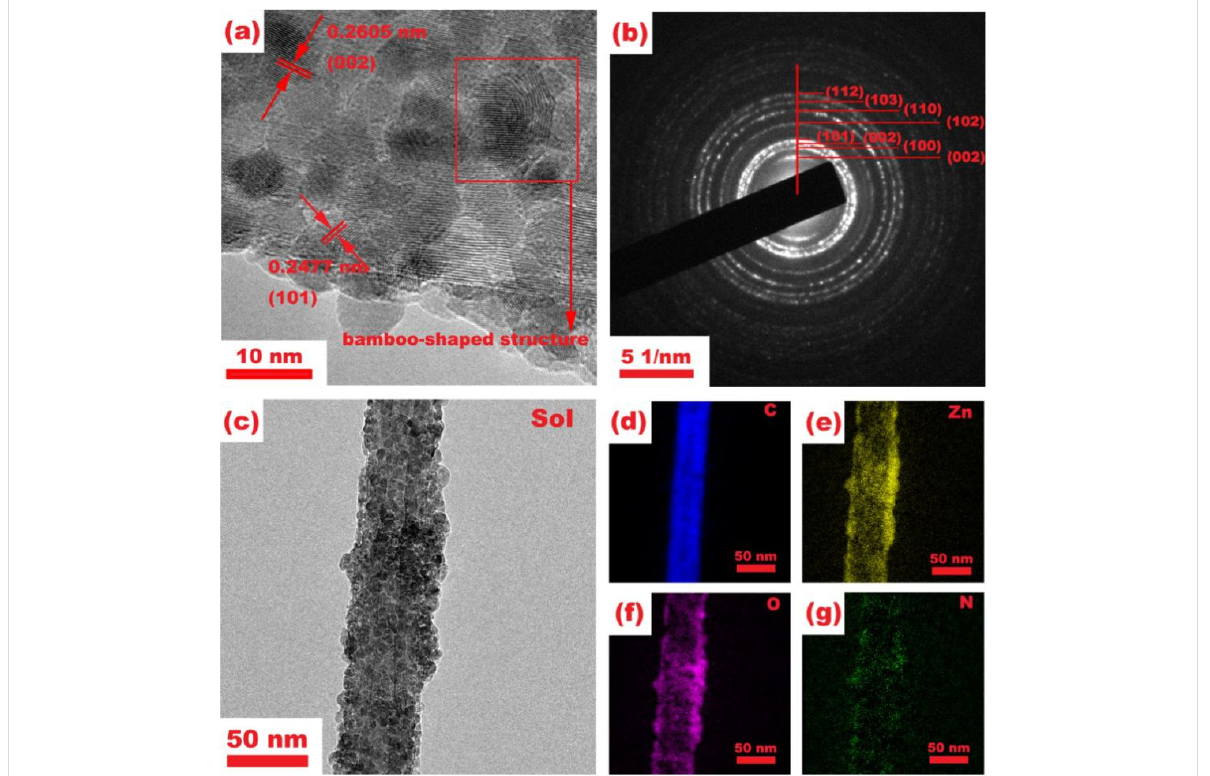
Figure 3: (a) HRTEM image; (b) SAED patterns; (c) TEM image; (d–g) EDX mapping images of the ZnO@NCNT composite.